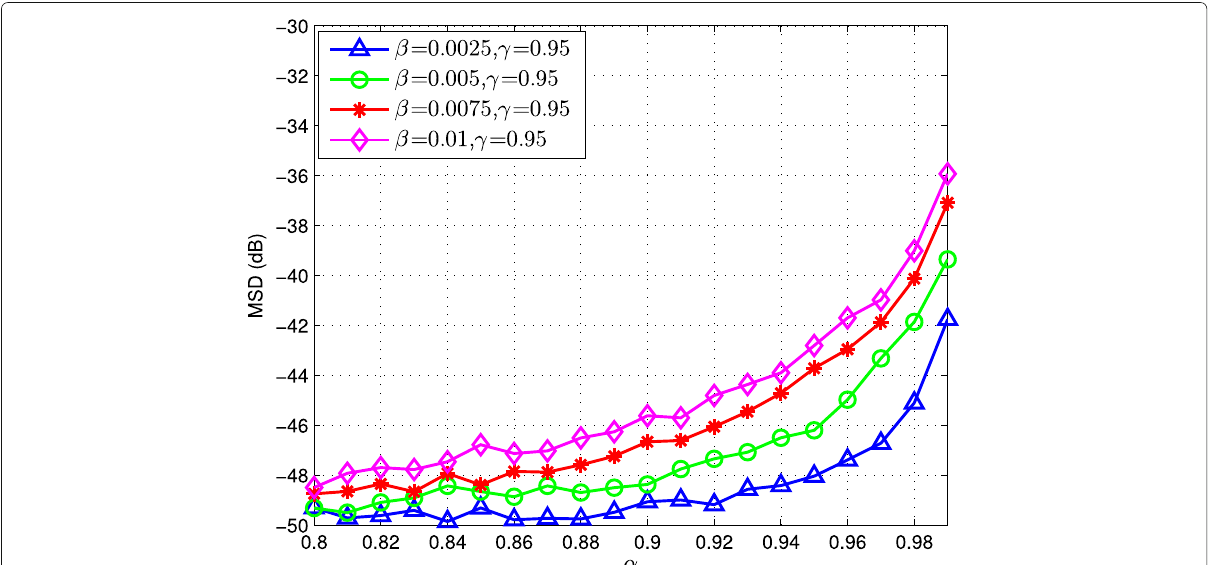
Fig. 4 Steady-state MSD versus α for different values of β for the LCTVFF mechanism when γ = 0.95